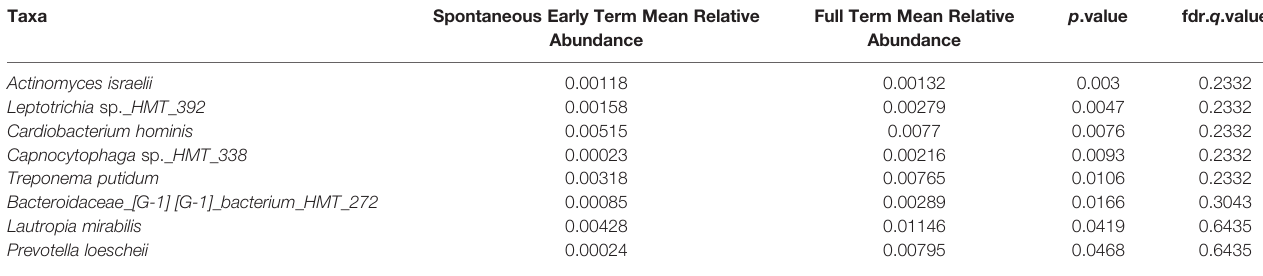
p .value fdr. q .value Full Term Mean Relative Abundance Abundance